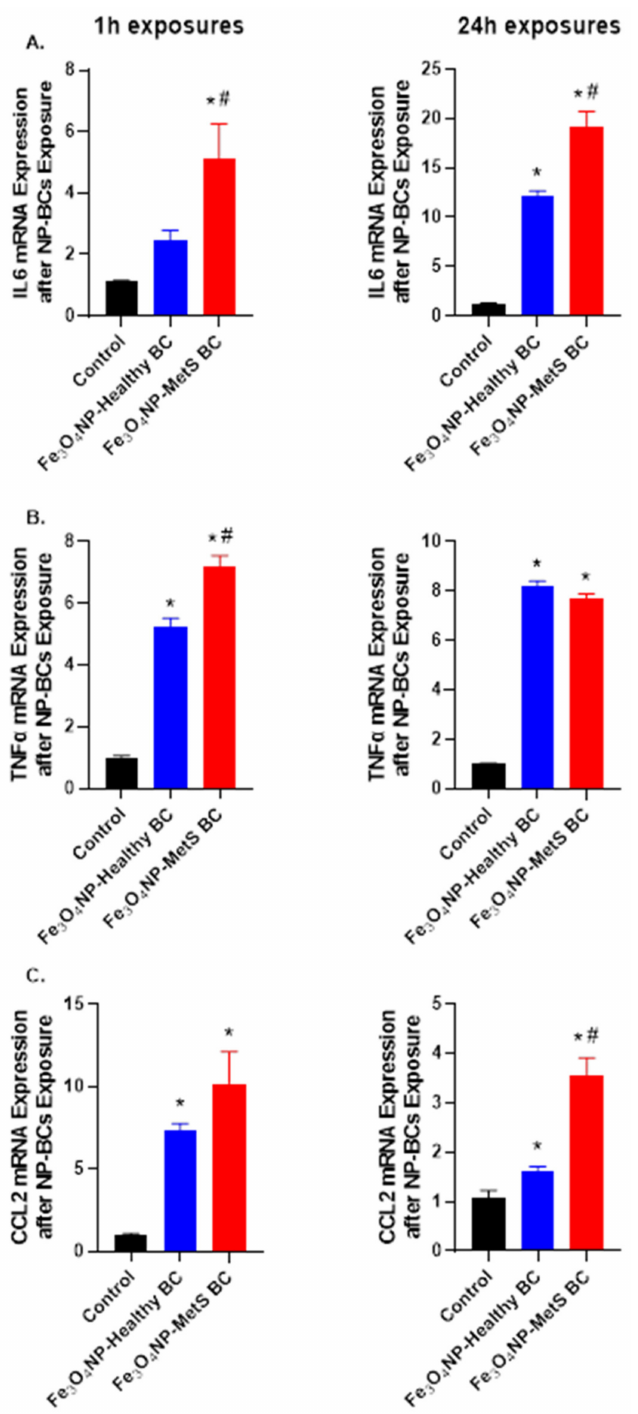
Figure 8. Alterations in inflammatory gene expression due to variations in the NP-BC. Changes in gene expression following exposure to Fe 3 O 4 NPs with a healthy or MetS BC. Expression of mRNA was assessed relative to serum-free media control cells (untreated). Cells were exposed to 25 µ g/mL of Fe 3 O 4 NPs with BCs for 1 h or 24 h (n = 5/group). Gene expression of IL6 ( A ), TNF α ( B ), and CCL2 ( C ), and GAPDH (housekeeping gene) was assessed through RT real-time PCR to evaluate the inflammatory responses due to BCs. * Denotes statistical significance compared to the expression of control group, # denotes statistical significance compared to the Fe 3 O 4 NPs with a healthy BC ( p <